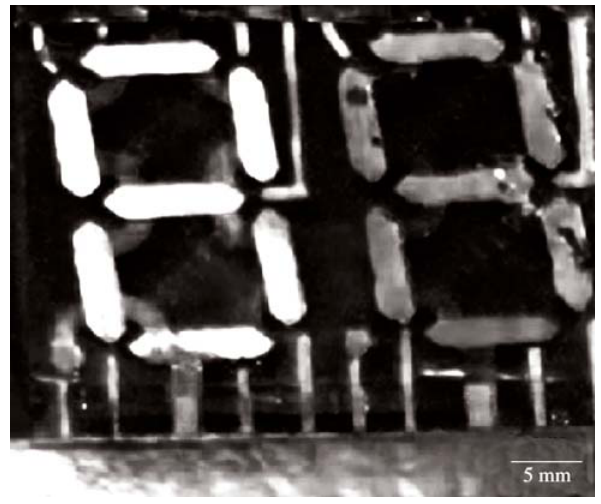
Figure 6. Photograph of two encapsulated 7 segments displays, made of FTO/PEDOT:PSS/OPPVDBC/Alq having all segments on, each one driven by a constant current of 7 mA; R. Lessmann et